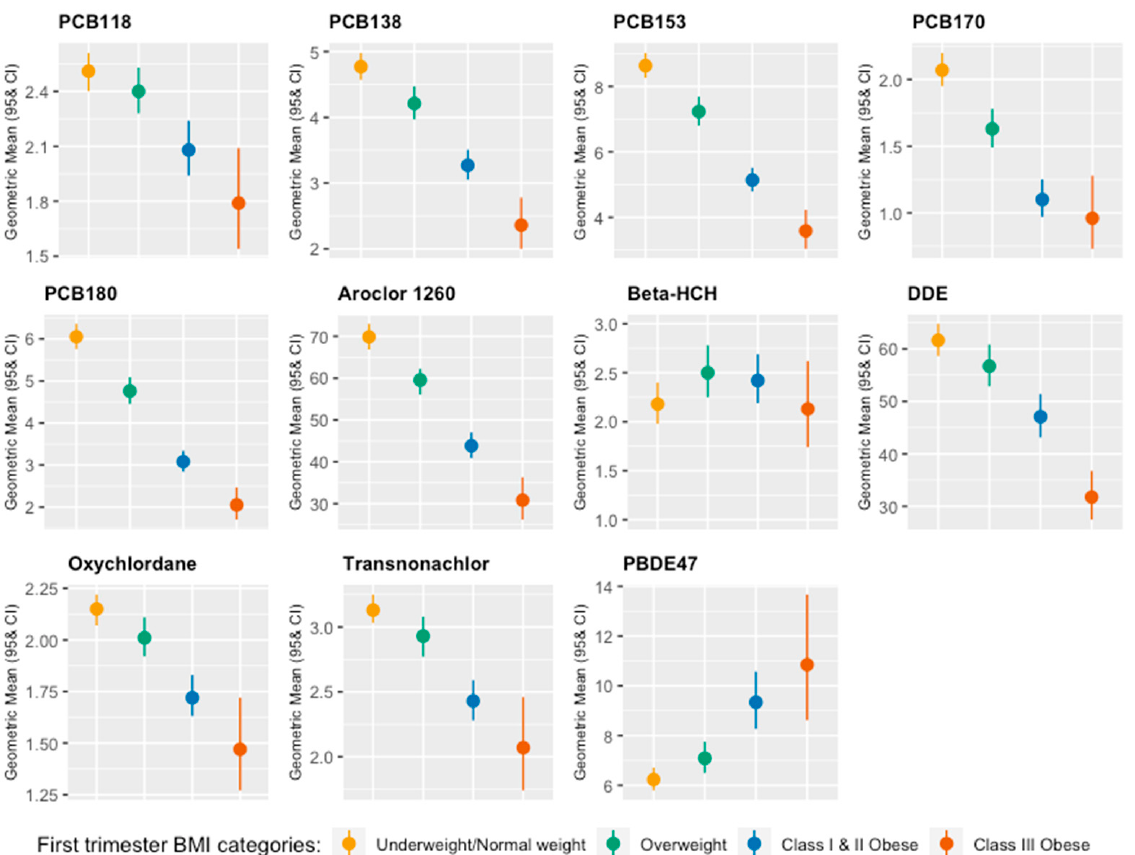
Figure 1. Geometric means and 95% confidence intervals (CI) of eleven POP concentrations by first- trimester BMI categories (colors illustrate BMI categories). N = 1912 pregnant people, MIREC Study. Table 3. Unadjusted and adjusted a associations [ β (95%CI)] between first-trimester body mass in- dex (BMI) category and lipid-adjusted persistent organic pollutant (POP) concentrations detected in at least 50% of the sample, MIREC Study b .